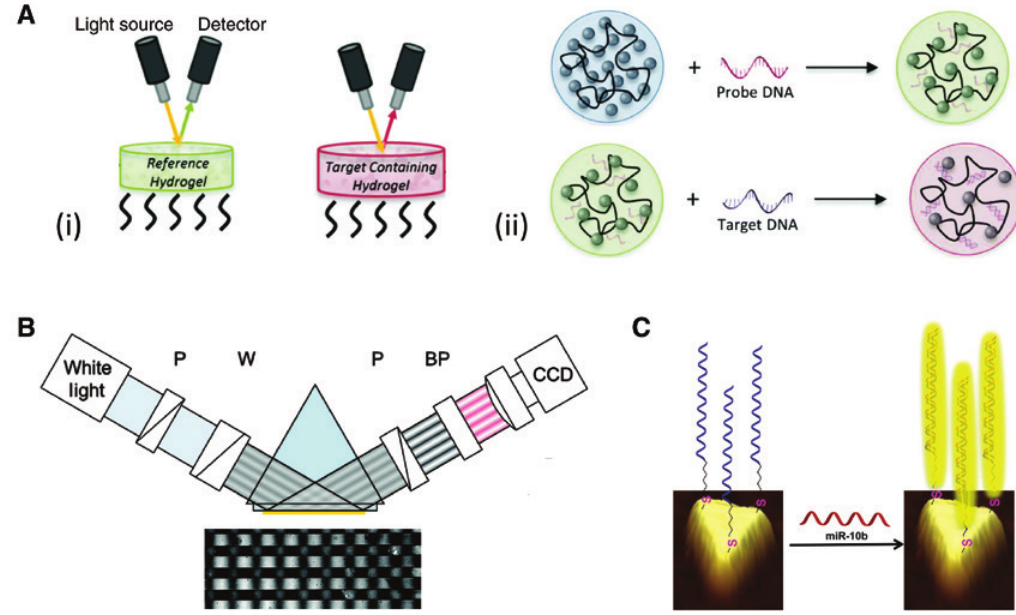
Figure 5: Label-free techniques for detection of NAs. (A) Hydrogel-embedded PC allows simple detection of DNA hybridization based on reflected light (i). Functionalization with probe strands and binding of target strands affect relative distance of PC beads and cause color shift (ii). Adapted from Ref. [57] with permission of The Royal Society of Chemistry. (B) Optical configuration of surface plasmon resonance phase imaging (SPR-PI), with polarizer P, wedge retard- ance plate W, and bandpass filter BP. An example of phase shift differences is also shown: horizontal stripes correspond to patterning with different biomolecular interactions, while vertical stripes are the imposed sinusoidal phase fringes. Adapted with permission from Ref. [58]. Copyright 2011 American Chemical Society. (C) Schematic representation of miRNA detection based on LSPR, superimposed to AFM image of nanometric gold nanoprisms functionalized with single-stranded DNA complementary to target RNA. Adapted from Ref.